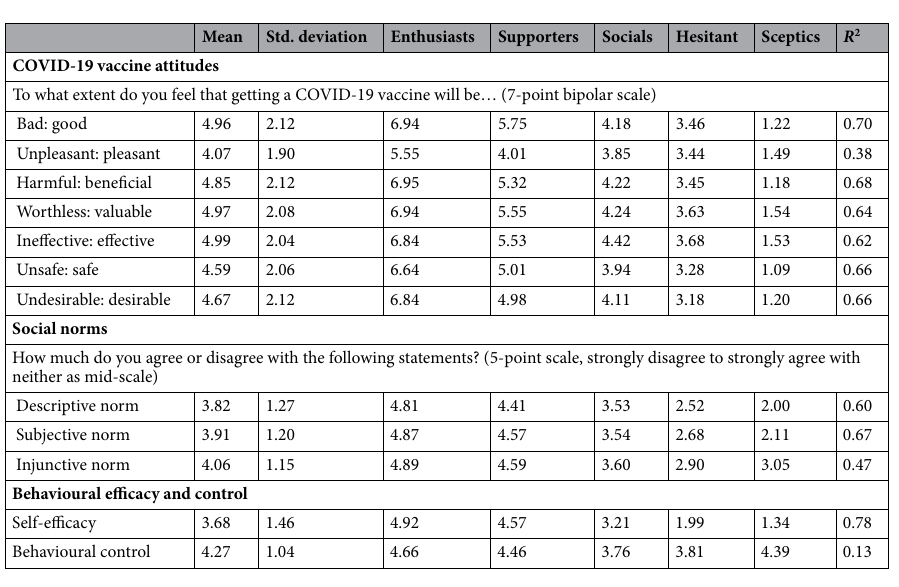
Table 2. Descriptive statistics of COVID-19 vaccine attitudes, social norms, and behavioural control across the segments. N = 1054. Table, sourced from Thaker et al., 2022 76 presents mean values of key input variables across the segments. All mean differences—as judged by ANOVA or chi-square tests—are significant at p < 0. 001. R 2 represents how much of the variance of each indicator is explained by this 5-cluster